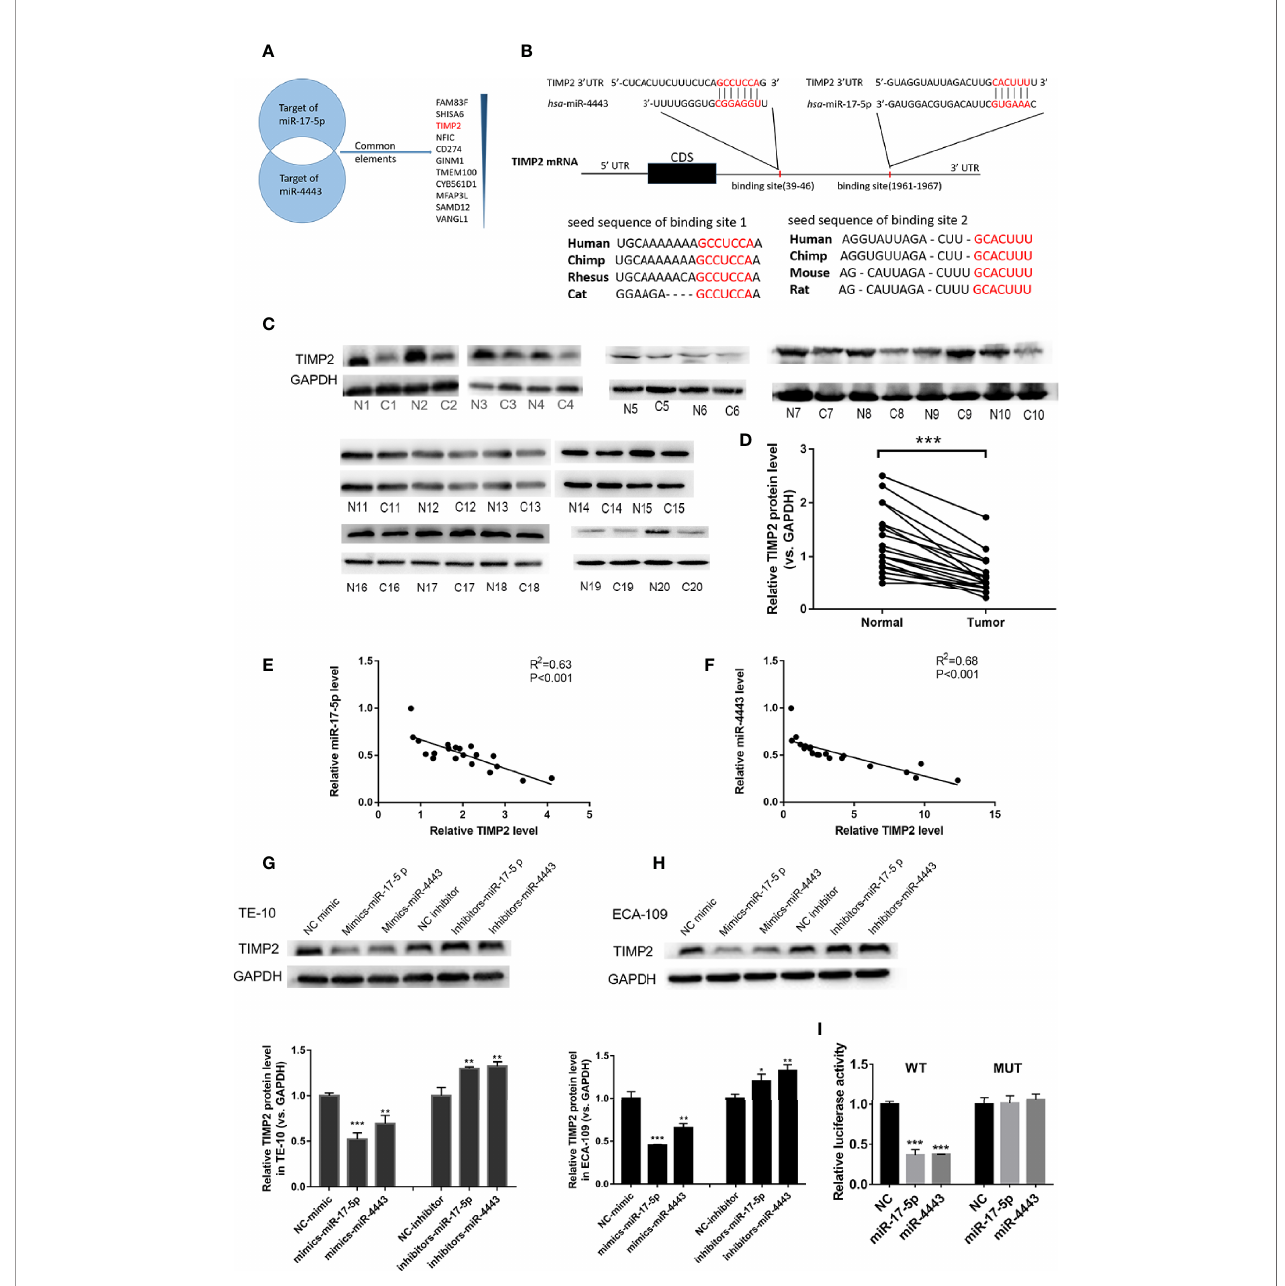
FIGURE 3 | TIMP2 is the target of miR-17-5p and miR-4443 in ESCC cells. (A) The common targets of miR-4443 and miR-17-5p. All targets are predicted by two bioinformatics tools and the common targets are arranged by the con fi dence level. (B) Graphic description of the base-pairing interaction between miR-17-5p, miR- 4443 and TIMP2 3 ’ UTR and their exact position in the TIMP2 mRNA. (C) Western blot analysis of TIMP2 in 20 pairs of ESCC tissues. (N=Normal, C=Cancer). (D) Quanti fi cation of TIMP2 levels in ESCC tissues. (E, F) Pearson ’ s correlation scatter plot of the fold changes of miR-17-5p, miR-4443 and TIMP2 protein ESCC tissues. (G, H) The effect of transfection of inhibitor-miR or mimic-miR or their negative control on the expression of TIMP2 in two cell lines, TE-10 (G) and ECA-109 (H) . (I) Dual luciferase activity assay was used to detect the binding af fi nity between miR-17-5p, miR-4443 and TIMP2. All results were shown as mean ± SD (n = 3). *p < 0.05, **P < 0.01, ***P <